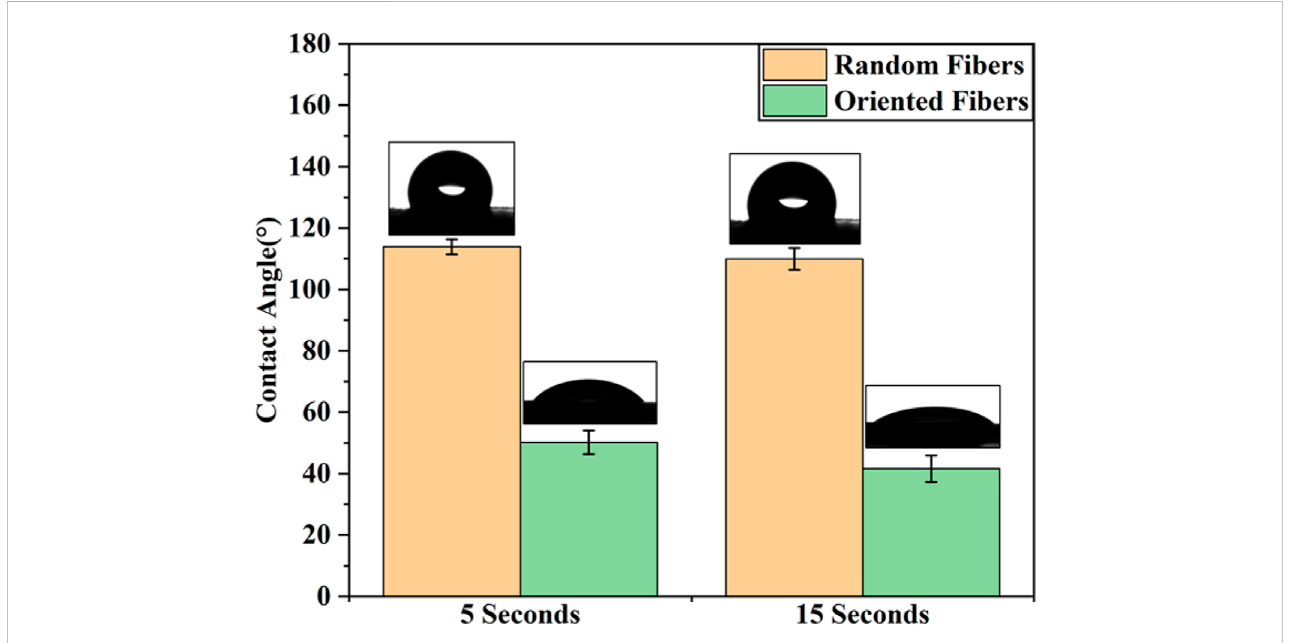
FIGURE 3 Contact angle of random- and oriented- fi ber membranes at different time points (N =